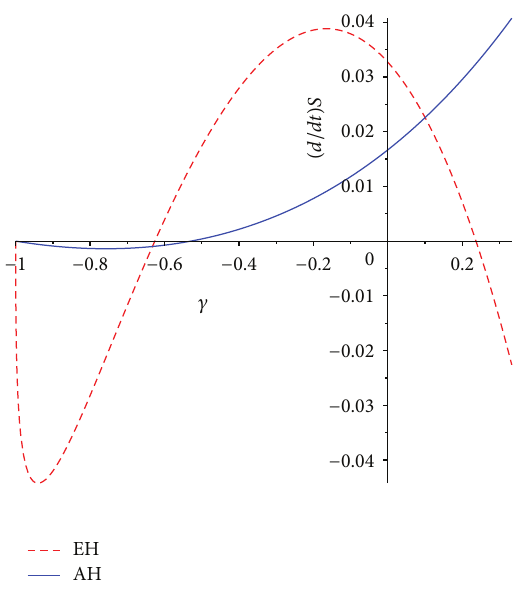
Figure 7: GSLT for DGP brane for Modified Chaplygin